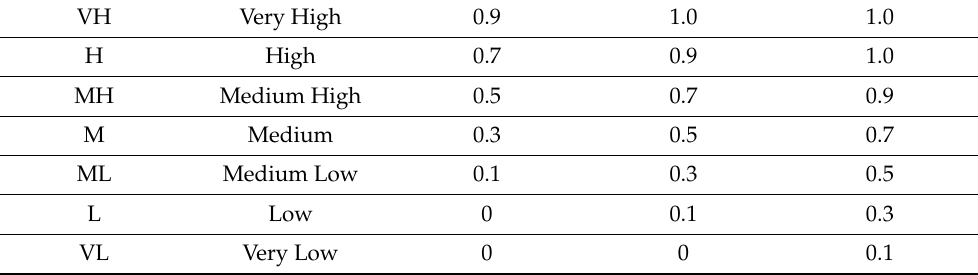
Table 1. The importance weights for linguistic variables of decision criteria. VH Very High